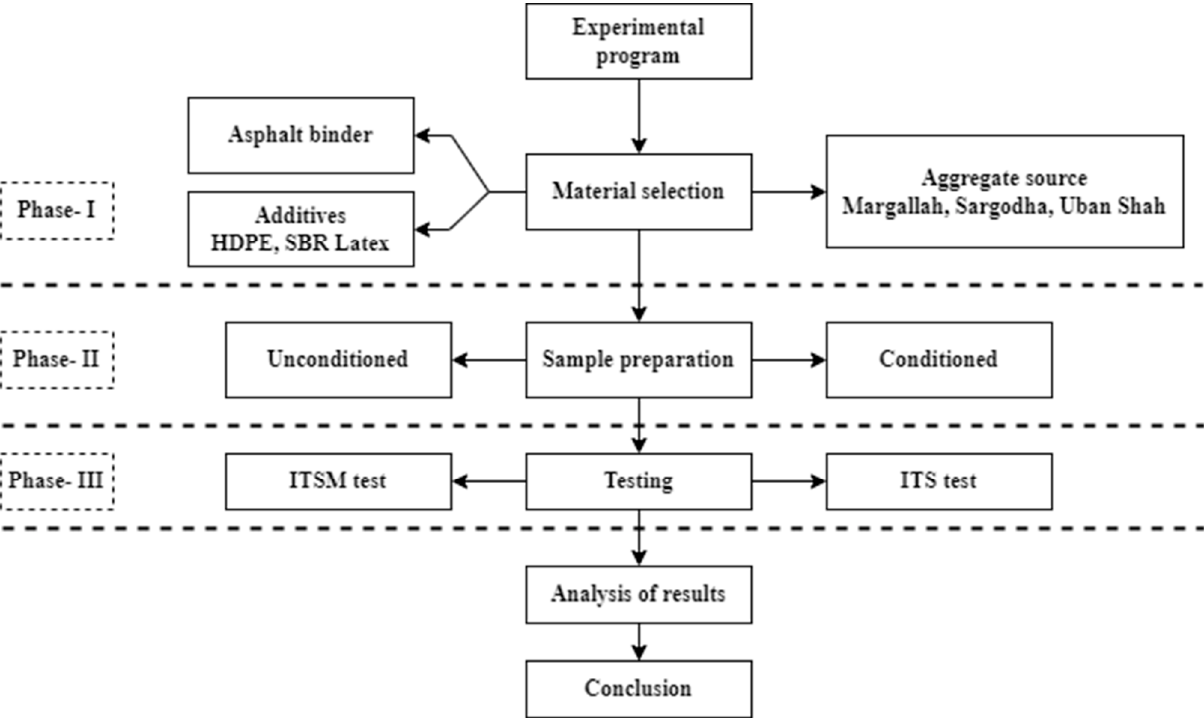
Figure 1 . Flowchart of the experimental design. Figure 1. Flowchart of the experimental design.